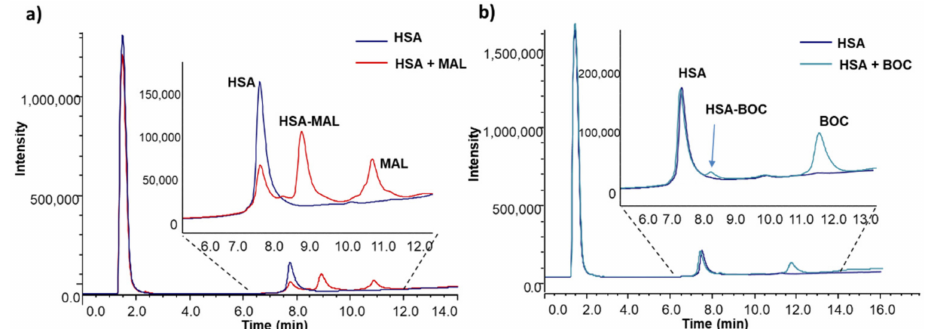
Figure 4. LC-MS analysis of adduct formation between HSA and MAL ( a ) or BOC ( b ). HSA concentration was 25 µ M while MAL and BOC concentration was 250 µ M, reaction buffer was potassium phosphate 50 mM, pH 7.4, incubation time was 30 min, and reaction temperature was 37 ◦ C. ( a ) Rt HSA = 7.7 min; Rt HSA- MAL adduct = 8.3 min; Rt MAL = 10.9 min. ( b ) Rt HSA = 7.7 min; Rt HSA- BOC adduct = 8.2 min; Rt BOC = 11.8